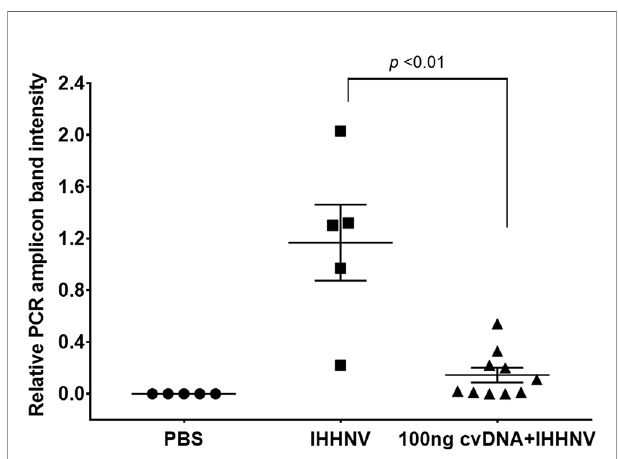
FIGURE 6 | Graph of average band density for IHHNV-PCR amplicons among shrimp ( P. vannamei ) injected with IHHNV only or with IHHNV plus